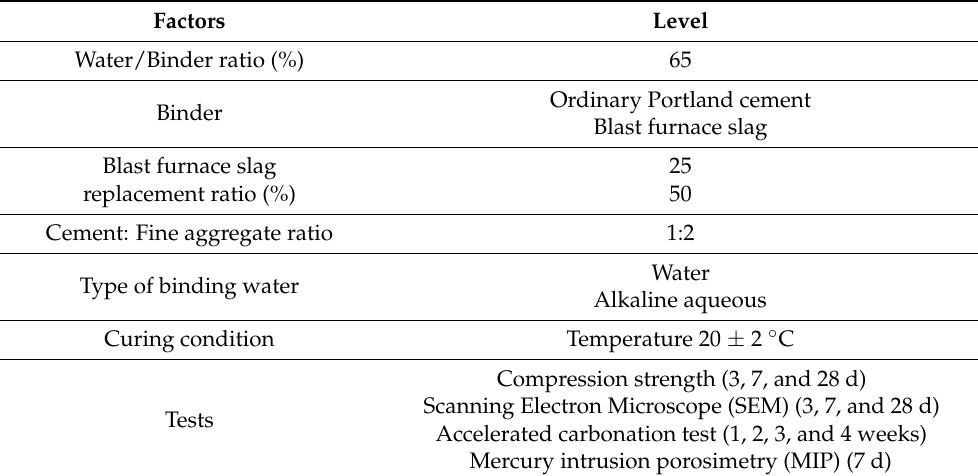
Table 1. Experimental plan.